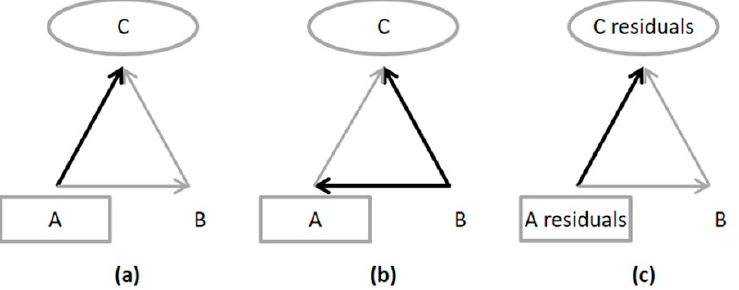
Figure 2. Regression models: ( a ) in the global effect calculation; ( b ) in the first step of the partial effect calculation; ( c ) in the second step of the partial effect calculation.